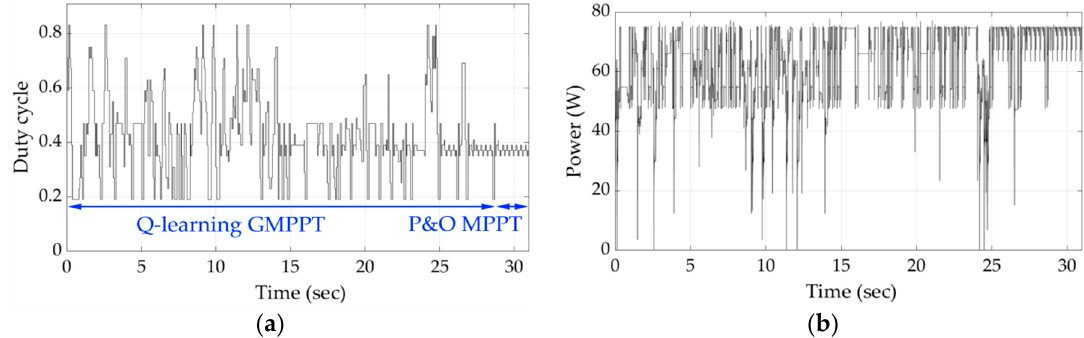
Figure 10. Results during execution of the proposed Q-learning-based GMPPT process for shading pattern 3: ( a ) duty cycle versus time and ( b ) PV array output power versus time.